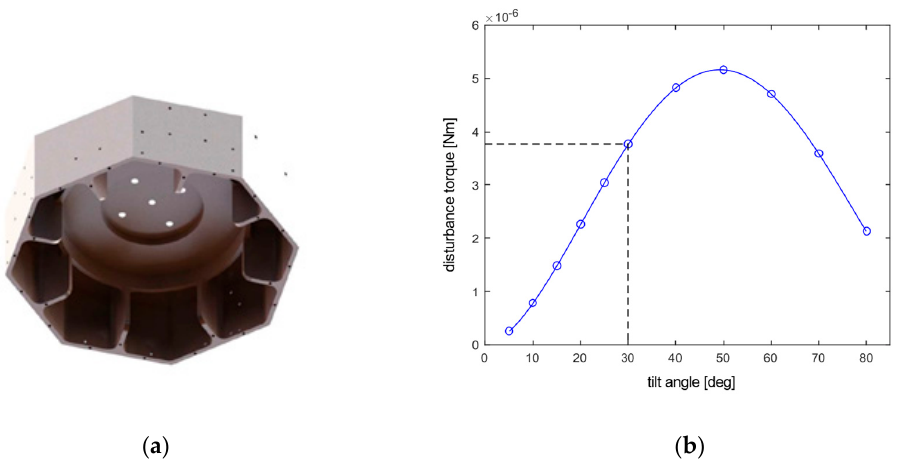
Figure 4. ( a ) Octagonal air-bearing platform for reduced deformation; ( b ) Torque due to elastic deformation as a function of the tilt angle, computed by FEM analysis.